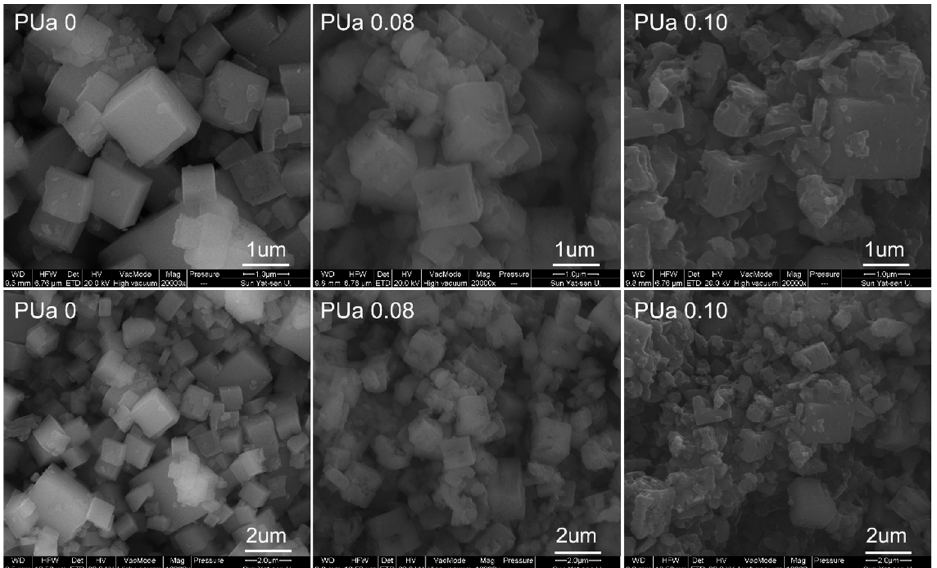
Figure 5. SEM images of the as-synthesized SAPO-34 samples with and without PUa as mesoporogen.